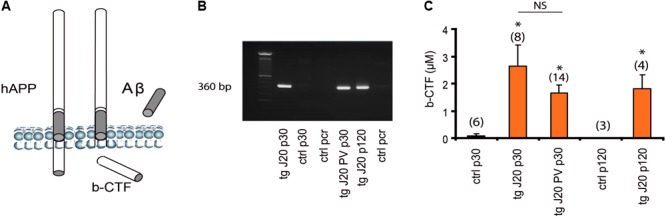
Accumulation of b-CTF in J20 mice. hAPP processing results in intracellular fragment b-CTF, the Aβ peptide and secondary products (A). Detection of hAPP gene by gel electrophoresis on a 1.5% agarose gel. 50- to 1,000-bp size markers; lane 1, J20-TG positive; lane 2, J20 Non-TG; lane 3, pcr ctl; lane 4 J20-PV-Cre and lane 5, J20-TG p120 (B). Levels of b-CTF at 30 and 120 days (C). Data are expressed as mean (± standard error of the mean) percentage of media control b b-CTF levels. (C) Both p30 J20-TG, and p30 J20-PV showed significant levels of b-CTF as detected in a sandwich ELISA (IBL, hAPP b-CTF Assay Kit, Japan). At p120 J20-TG mice showed more that 50% increase in b-CTF (C). Neither of the control had any significant b-CTF levels (C), p < 0.005, data are expressed as mean (± standard error of the mean) percentage of media control b-CTF levels. ∗p < 0.005 and NS p > 0.05.